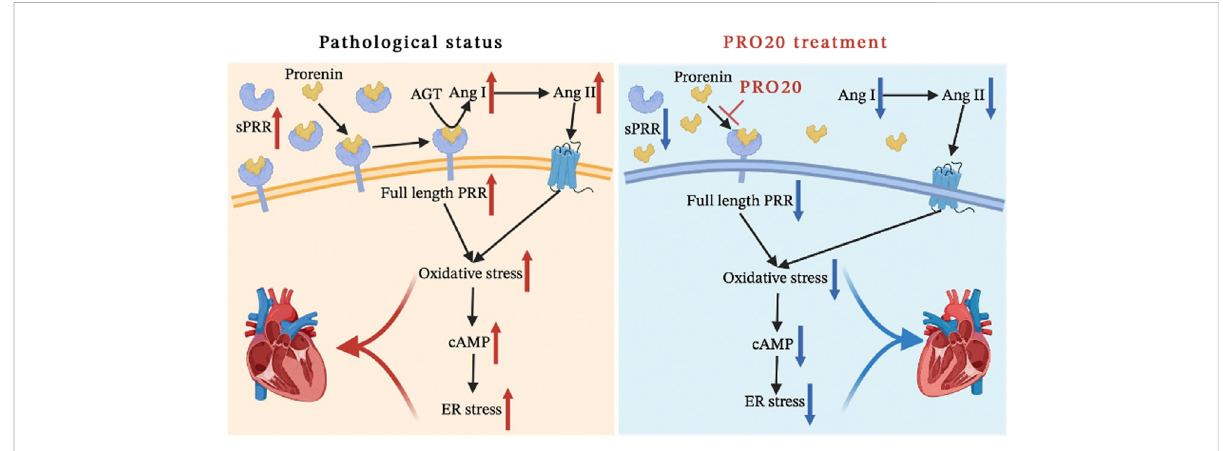
FIGURE 7 Schematic diagram of the mechanism. We systematically analyzed the mechanism of the PRO20 effect on cardiac remodeling, and found that PRO20 inhibited both oxidative stress and ER stress signaling